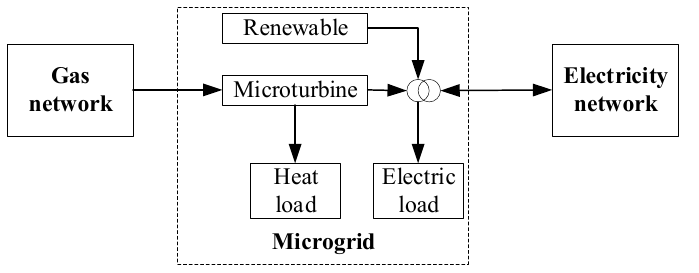
Figure 2. Structure of dual grid-interfaced LESs. According to their connection states with energy networks, the operation of LESs can be divided into the following modes.